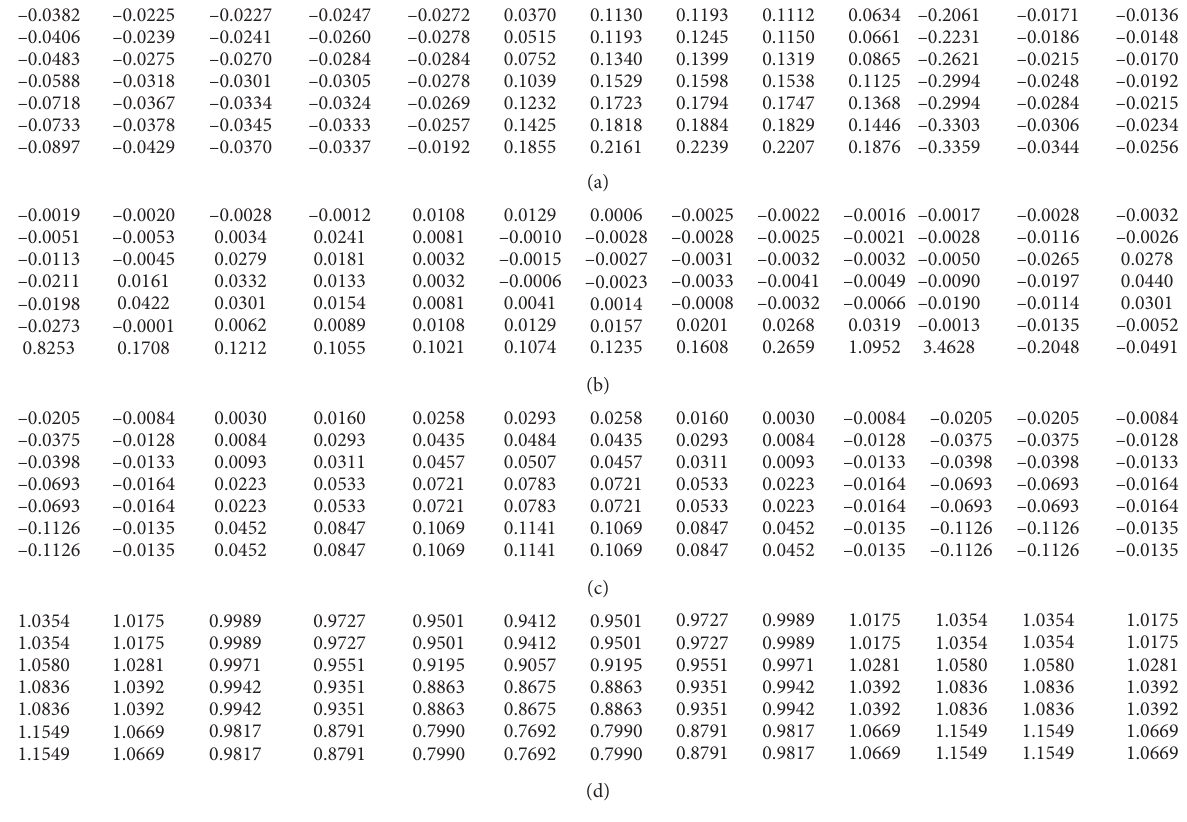
Figure 4: Some examples of data generation. (a) Example of laminar flow data. (b) Example of multidrop flow data. (c) Example of core flow data. (d) Example of circle flow data.